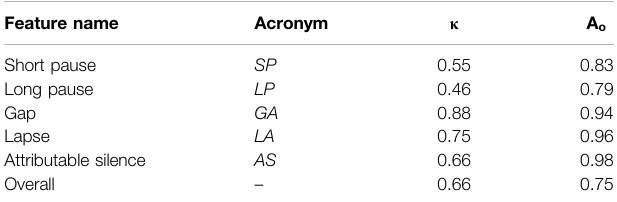
TABLE 3 | Inter-annotator agreement: Cohen ’ s kappa ( κ ) and observed agreement ( A o